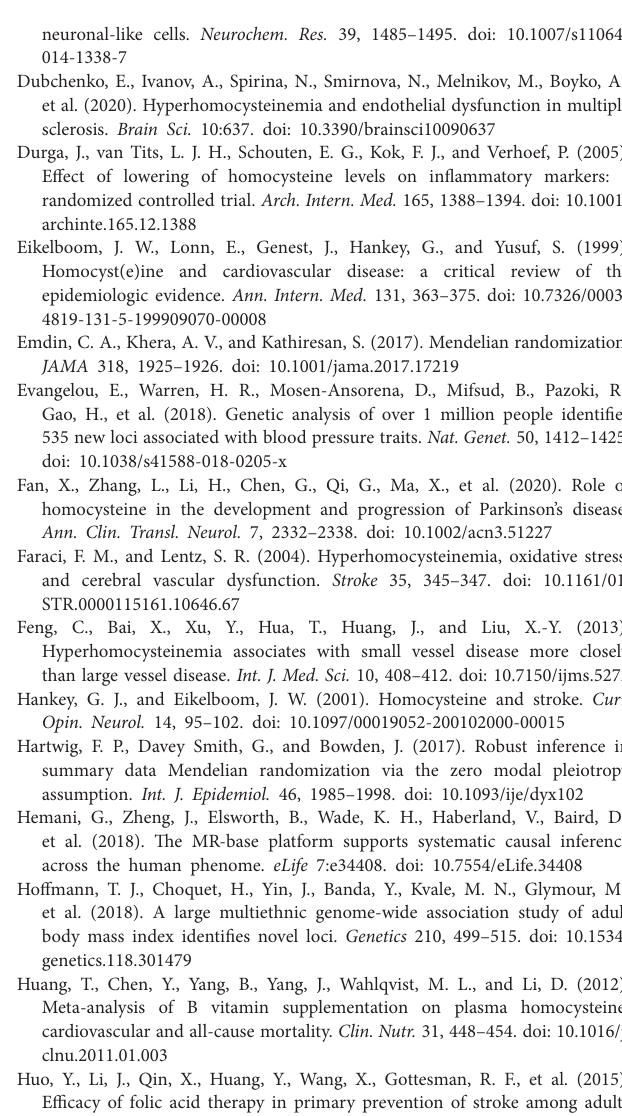
Supplementary Figure S2 | Forest plot of the effect of plasma Hcy level on cerebrovascular and neurodegenerative disease. IS, ischemic stroke; LAS, large artery atherosclerosis stroke; CES, cardio-embolism stroke; SAS, small artery occlusion stroke; TIA, transient ischemic attack; MS, multiple sclerosis; AD, Alzheimer’s Disease; PD, Parkinson’s disease; ALS, amyotrophic lateral sclerosis; FTD, frontotemporal dementia. The dot and the bar indicated the causal estimate of plasma Hcy level on risk of cerebrovascular and neurodegenerative disease. Supplementary Figure S3 | Scatter plot and leave-one-out analysis of the effect of plasma Hcy level on ischemic stroke caused by small artery occlusion. MR, Mendelian randomization; SNPs, single nucleotide polymorphisms; Hcy, homocysteine; SAS, small artery occlusion stroke. (A) Scatter plot: each black dot indicated a SNP, plotted by the estimate of SNP on plasma Hcy level and the estimate of SNP on the risk of ischemic stroke caused by small artery occlusion with standard error bars. (B) Leave-one-out analysis: the dot and the bar indicated the estimates and 95% CI when the specific SNP is removed. 3-SNPs: rs1801133, rs9369898, and rs548987. 7-SNPs: rs1801133, rs9369898, rs548987, rs4660306, rs2251468, rs838133, and rs12780845. 13-SNPs: